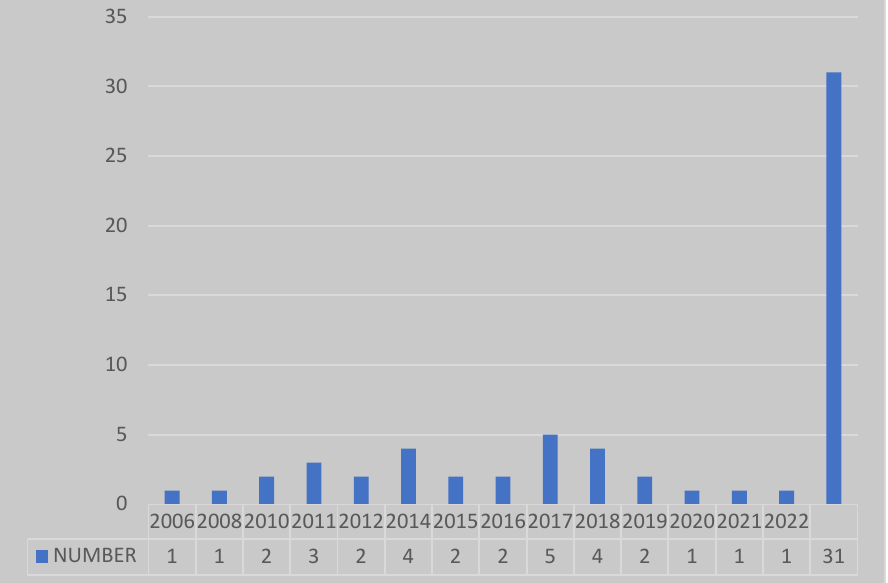
Figure 4. Journals (Wos and Scopus). Of the total 31 articles, almost half (13 articles) were published exclusively in two journals, Corporate Social Responsibility and Environmental Management, with an impact factor (SJR) of 1.67, quartile 1; and the Journal of Cleaner Production, with SJR of 1.62, quartile 1. This concentration in the two journals (about 47%) is associated with the scope of the journals. Regarding Figure 5, it can be seen that China has only one author with publications, which corroborates Rodrigues and Mendes (2018), who concluded that this country still has a shortage of studies on the mining sector while being one of the biggest contributors to the global mining industry.